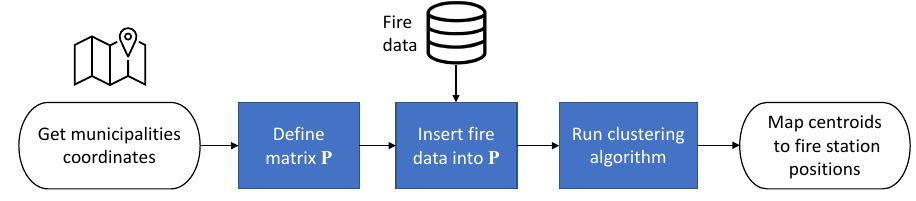
Figure 4. Block diagram of the proposed approach for fire station